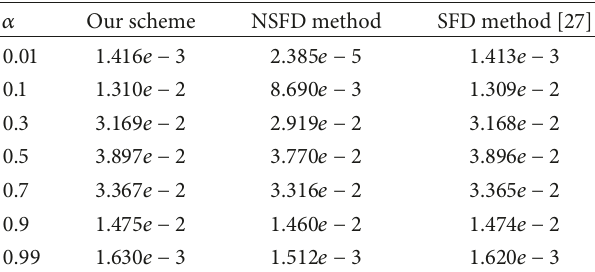
plotted for 𝛼 = 0.8 , 0.9 , and 0.99 at 𝑇 = 1 in Figure